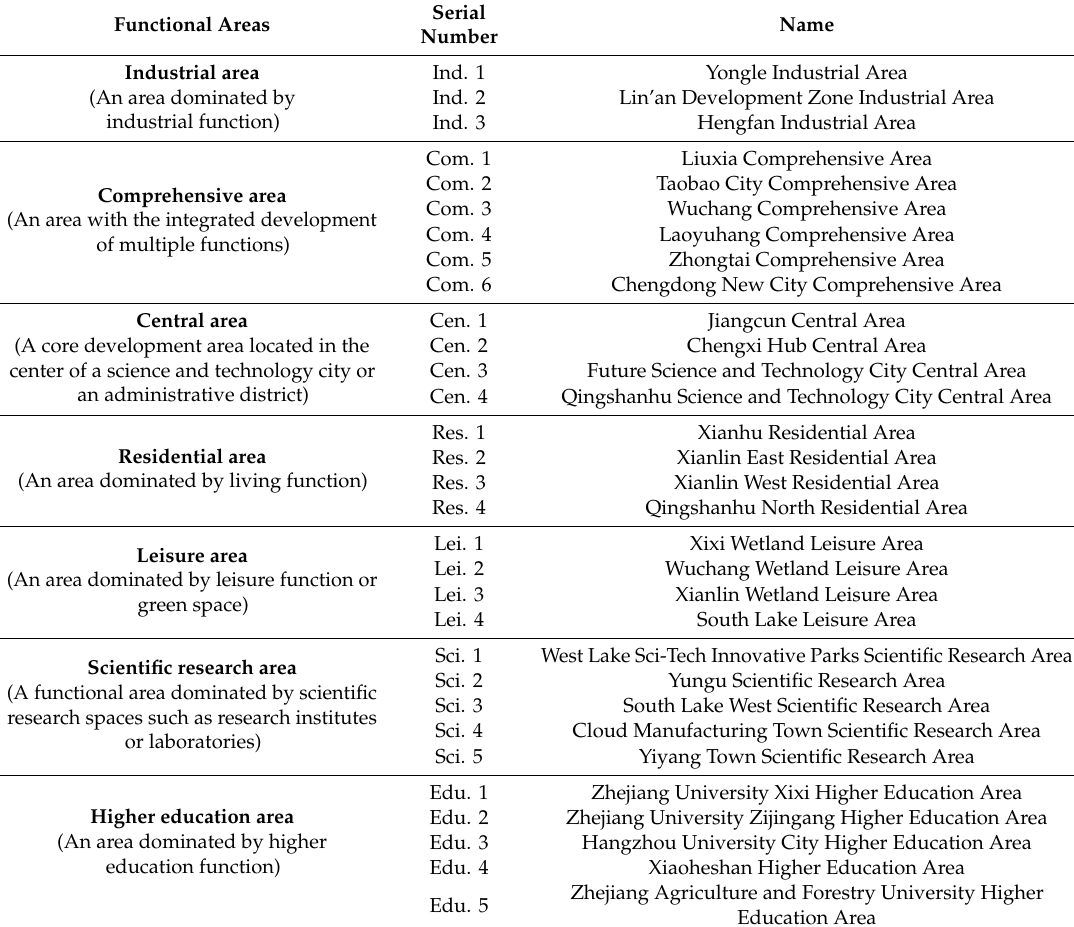
Table 1. List of functional